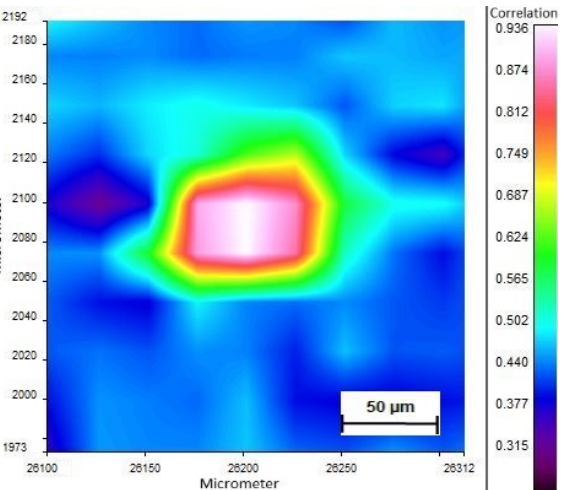
Figure 3. Polystyrene particle detected in the meconium sample. FTIR image displays the correlation value with polystyrene.